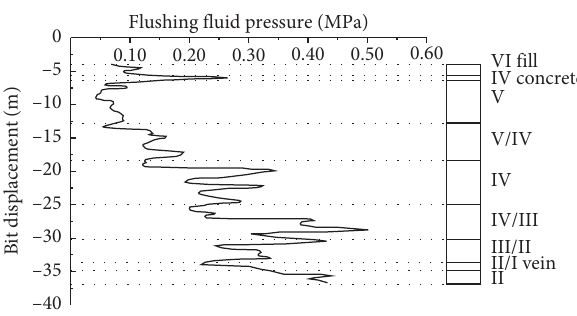
Figure 6: Flushing fluid pressure change graph.